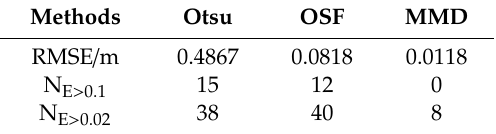
Table 2. Root mean square errors (RMSEs) and error measurements of Otsu, OSF and MMD methods.